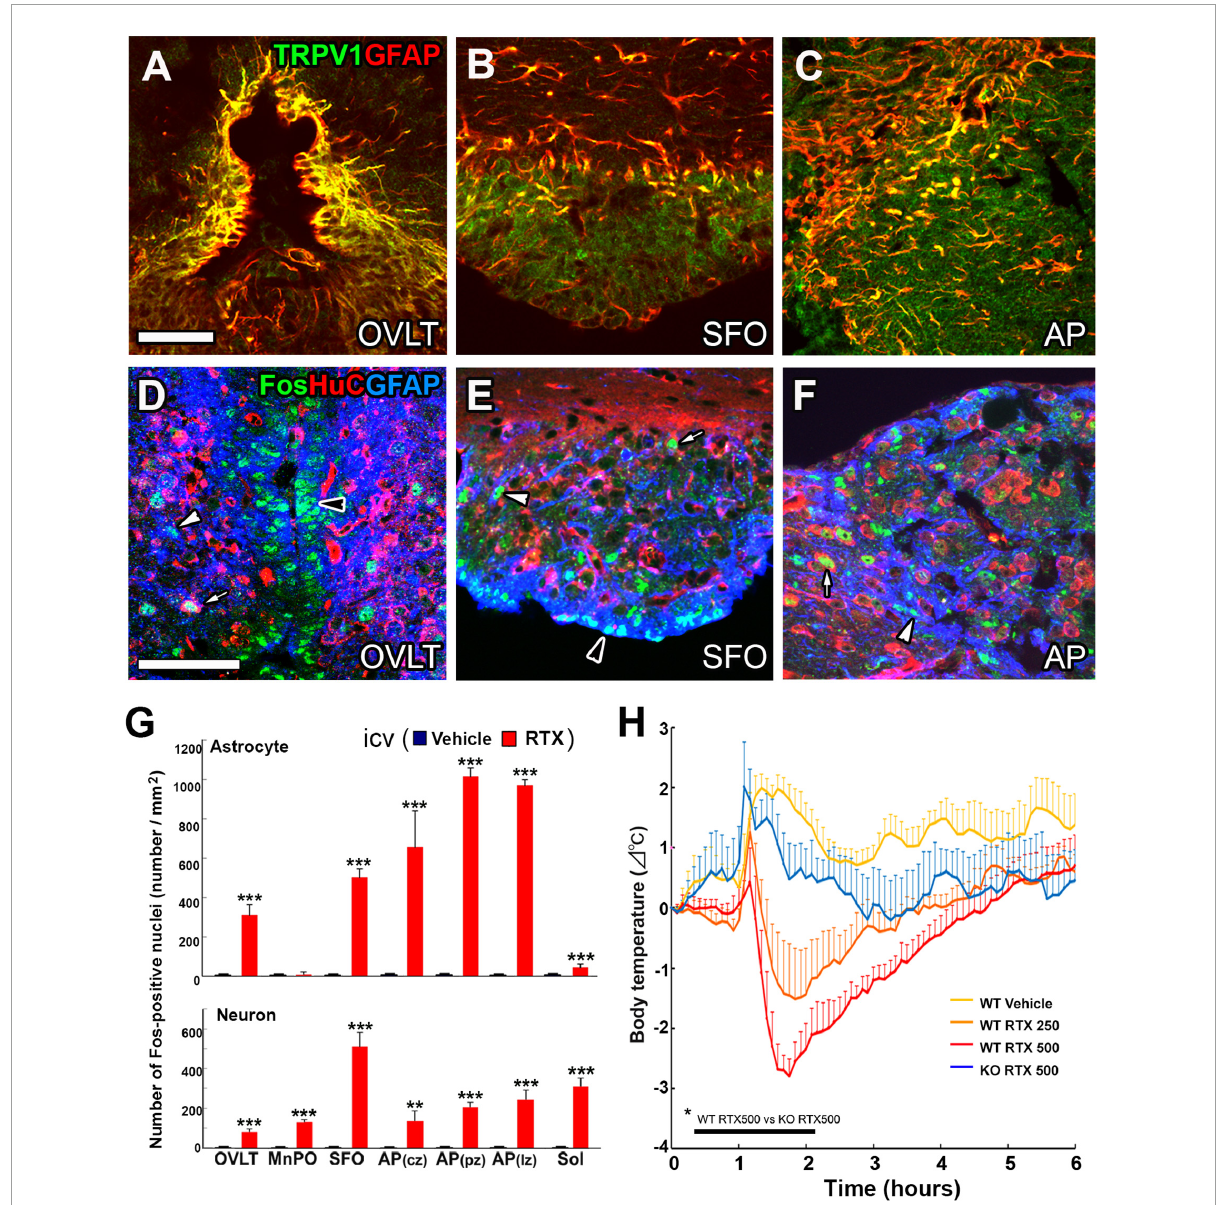
FIGURE7 Prominent TRPV1 and TRPV1-dependent Fos expression at astrocytes in the CVOs of adult mouse brain and hypothermia by central activation of TRPV1. The expression of TRPV1 is prominent at GFAP + astrocytes in the CVOs (A–C) . The i.c.v. infusion of the TRPV1 agonist resiniferatoxin at 500 ng/kg causes prominent Fos expression at astrocytes rather than neurons in the CVOs (D–F) . AP, area postrema; GFAP, glial fibrillar acidic protein; OVLT, organum vasculosum of the lamina terminalis; SFO, subfornical organ. Scale bars = 50 µ m. Quantitative analysis shows central infusion of resiniferatoxin induces significant Fos expression at astrocytes preferentially in the CVOs and at neurons in the CVOs and neighboring brain regions (G) . The i.c.v. infusion of the TRPV1 agonist resiniferatoxin induces hypothermia in a dose-dependent manner in WT mice, but not in TRPV1 KO mice (H) . ** p < 0.01, *** p 0.001 between WT and TRPV1 KO mice with unpaired Student’s t -test (G) or an ANOVA with Tukey’s post-hoc -test (H) . Photographs and graphs are rearranged with permission from John Wiley & Sons [ (A–G) Mannari et al.,